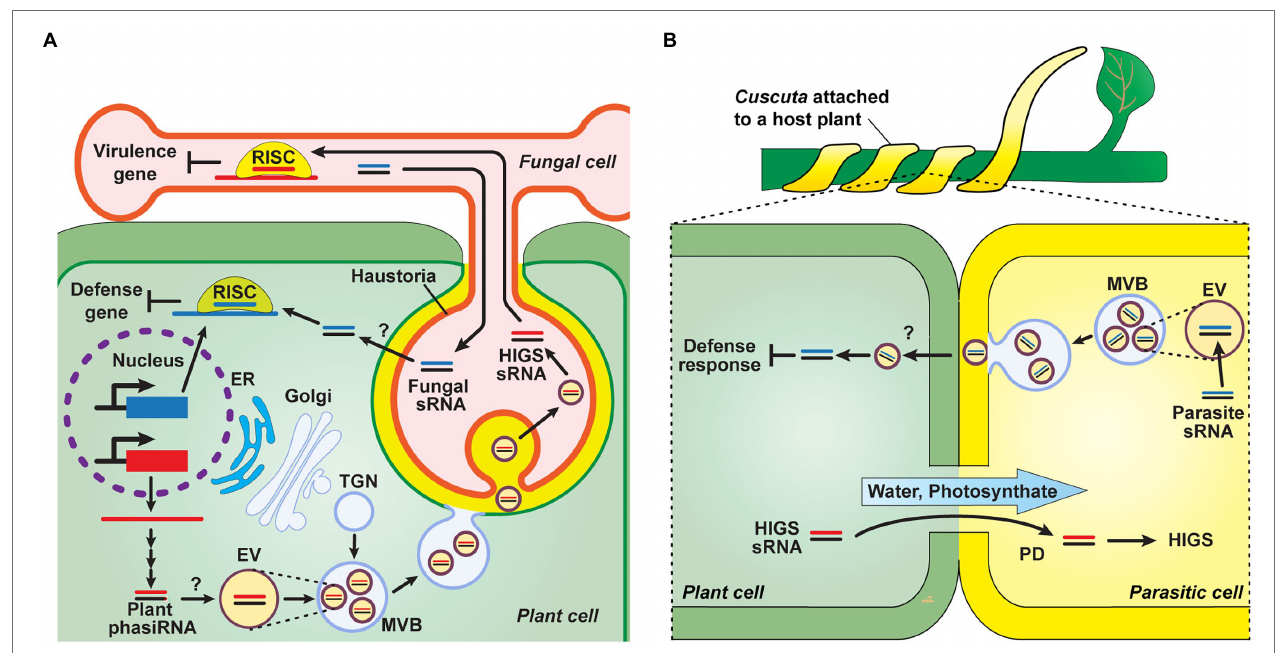
FIGURE 5 | Genetic communication between plants and other organisms, via mobile sRNAs. (A) Plant-microbe sRNA-mediated interactions. Plants generate phasiRNAs, which are contained in EVs, are delivered into fungal pathogens, e.g., Phytophthora , to target pathogen virulence genes to downregulate their expression as a means for plant defense. These EVs are formed within the lumen of MVBs that then deliver these EVs to pathogen cells, at the host-pathogen interface (haustoria), via MVB fusion to the host plasma membrane and subsequent uptake into the cytoplasm of pathogen cells. Internalized sRNAs are incorporated into RNA-induced silencing complexes (RISC) to activate host-induced gene silencing (HIGS), which can suppress the virulence of plant pathogens. As a counter-defense strategy, pathogen-derived sRNA might be secreted into the host plant, via potential endocytic pathways, and recruited in host RISC to silence plant defense genes. TGN, trans -Golgi network; MVB, multivesicular body; and EV, extracellular vesicle (Zhang et al., 2016a; Cai et al., 2018; Baldrich et al., 2019; Hou et al., 2019; Ren et al., 2019; Karimi et al., 2022). (B) Hypothetical model of sRNA trafficking between host plants and the parasite Cuscuta . Similar to sRNA transport between plants and fungi (A) , sRNAs may be loaded to EVs within parasitic plants and exported into the apoplast. Apoplastic movement of sRNAs from parasitic to host plants then mediates in silencing of host defense responses, at the infection sites. The formation of PD, between cells of the host and parasite, establish a symplasmic path for movement of both photosynthate and host sRNA into the parasitic plant (Alakonya et al., 2012; Bandaranayake and Yoder, 2013; Dubey et al., 2017; Shahid et al., 2018; Johnson et al., 2019; He et al.,